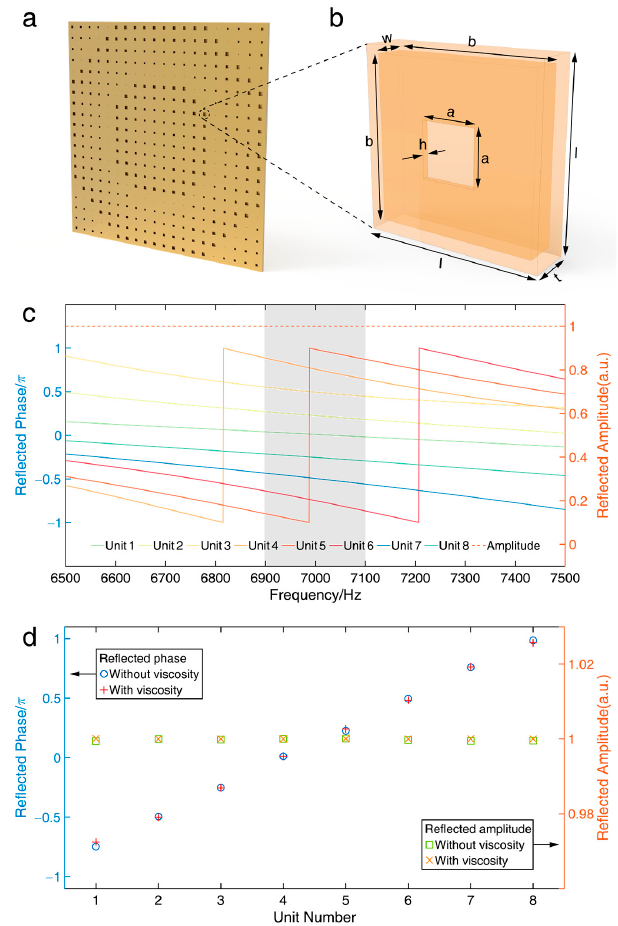
Figure 3. Unit cell of the hologram and the thermoviscous analysis. ( a ) Perspective view of an acoustic metasurface hologram. The designed hologram consisted of 400 unit cells. ( b ) A typical unit cell of the metasurface. The side length and the thickness of each unit cell were determined (d = 10 mm, t = 2.5 mm) while other three parameters (i.e., a, b, and h) were variable. ( c ) The reflected amplitudes and phases of unit cells under the frequency range between 6.5 kHz and 7.5 kHz. The scattering phase can be modulated by altering the geometry characteristics of the cavity. ( d ) Amplitude and phase shift profiles at 7.0 kHz with and without considering thermoviscous effects.